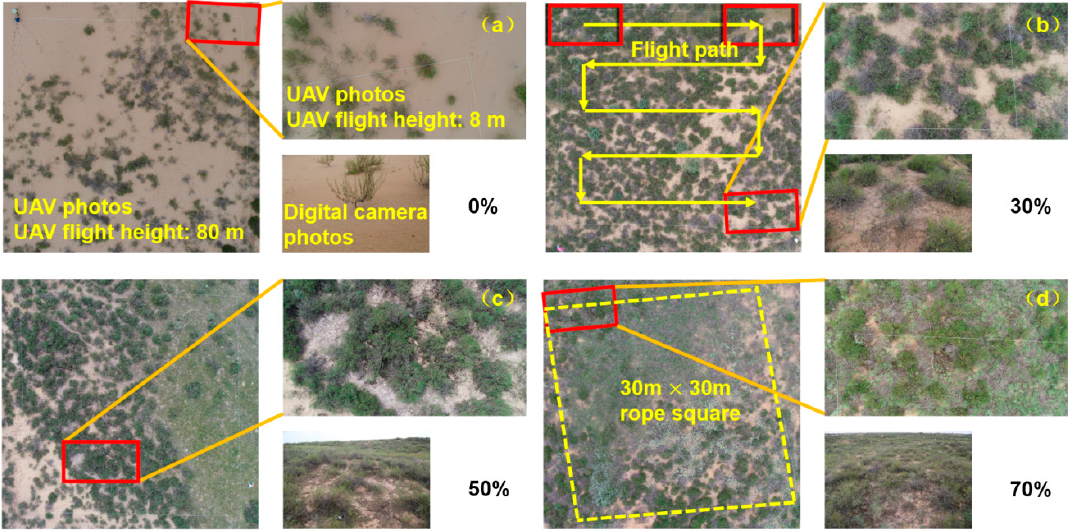
Figure 3. Quadrat survey units of ( a ) 0%, ( b ) 30%, ( c ) 30%, ( d ) 70% BSC coverage.